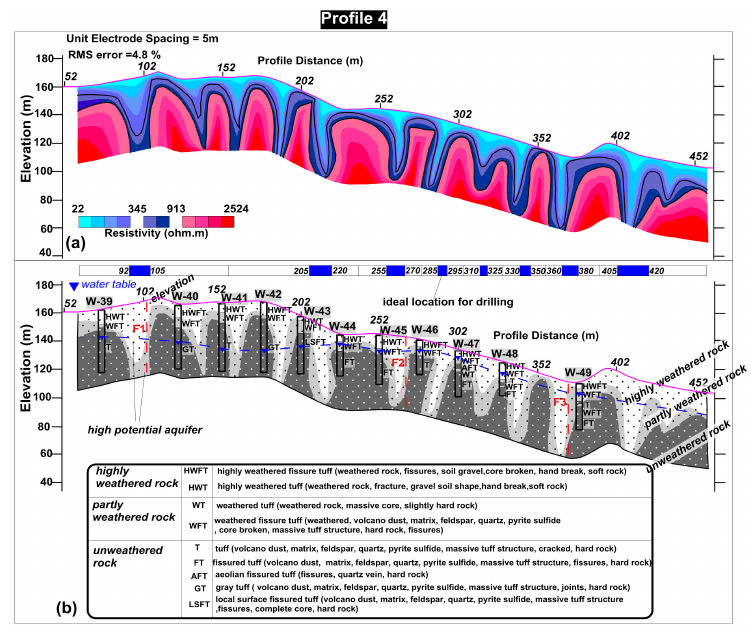
Figure 12. Electrical image along profile 3 ( a ) model resistivity with topography ( b ) interpreted model resistivity with topography.